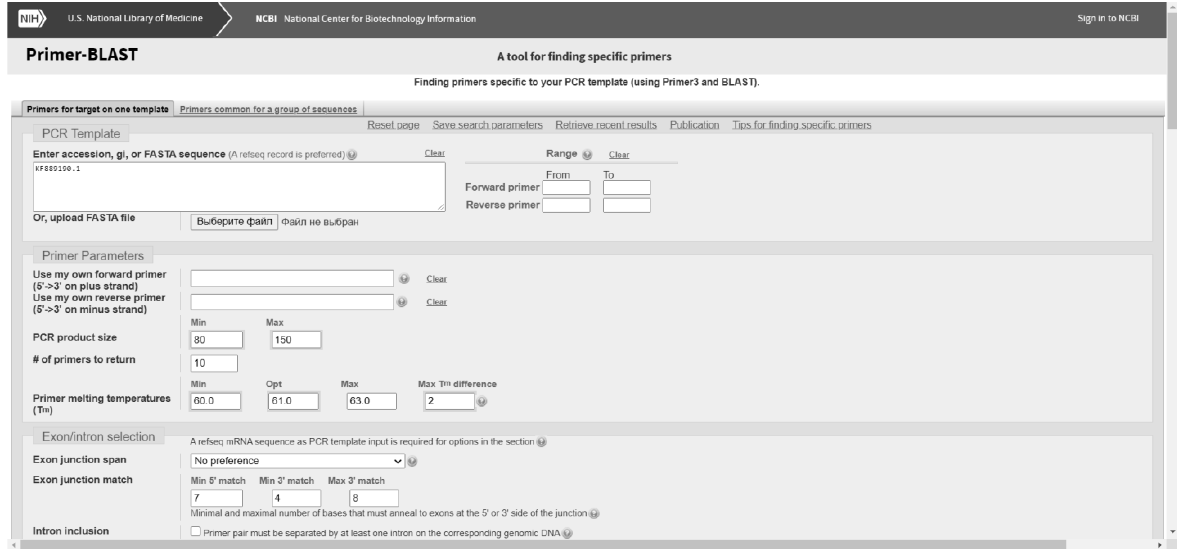
Figure 1. The screen of